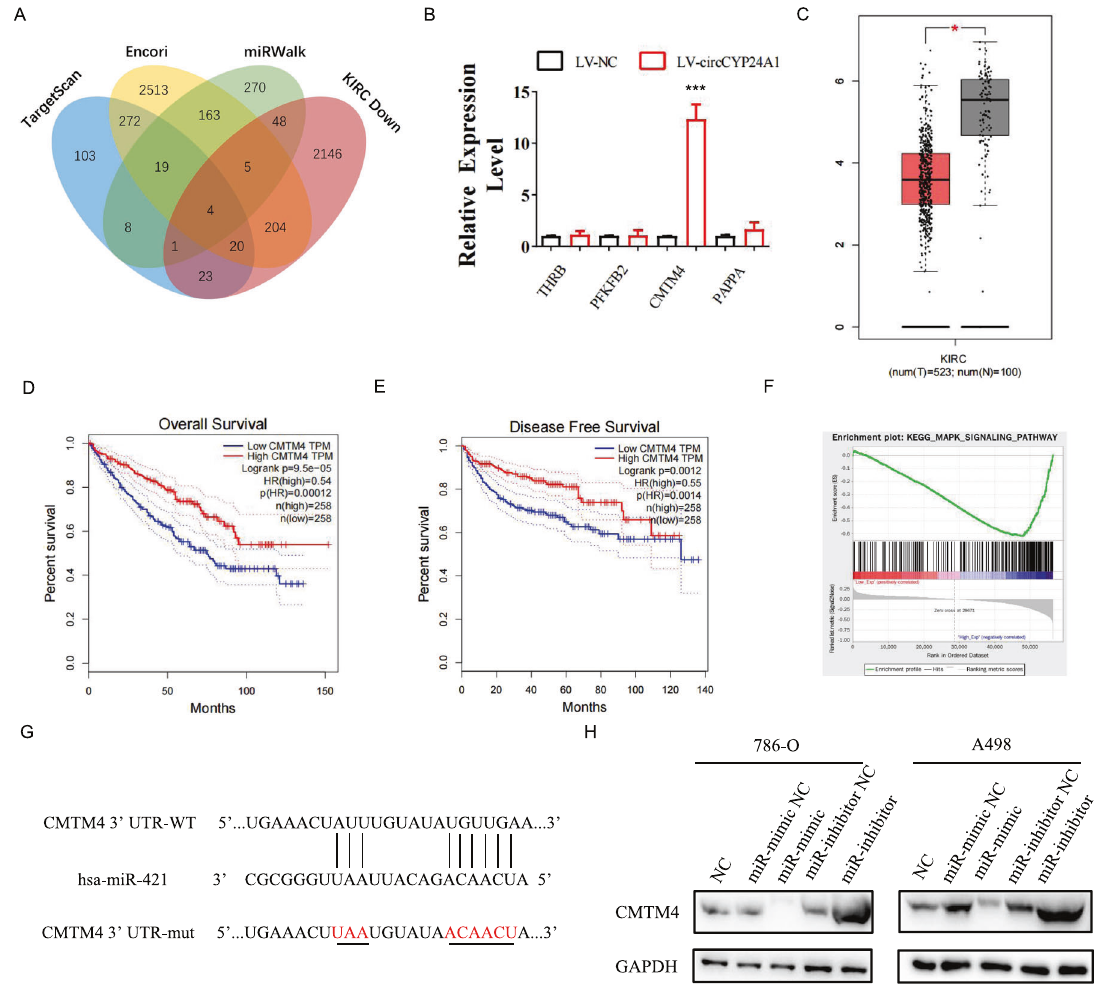
database. B Relative expression of THRB, PFKFB2, CMTM4, and PAPPA was measured using qRT-PCR in 786-O cells transfected with LV-NC or LV-circCYP24A1. C CMTM4 TPM expression in the tumor tissues compared with the normal tissues in TCGA-KIRC database. Overall survival ( D ) and disease-free survival ( E ) were measured using the Kaplan – Meier analysis. F Gene-set enrichment analysis of the MAPK signaling pathway in patients from TCGA-KIRC with high/low CMTM4 expression. G The predicted binding site for circCYP24A1 and miR-421 is illustrated. Mutant and wild-type CMTM4 constructs for dual-luciferase reporter assays were generated. H CMTM4 expression was detected using Western blotting in 786-O and A498 cells transfected with miR-421 mimic, miR-421 inhibitor, or its normal control. Data are presented as means ± SD. *** p <